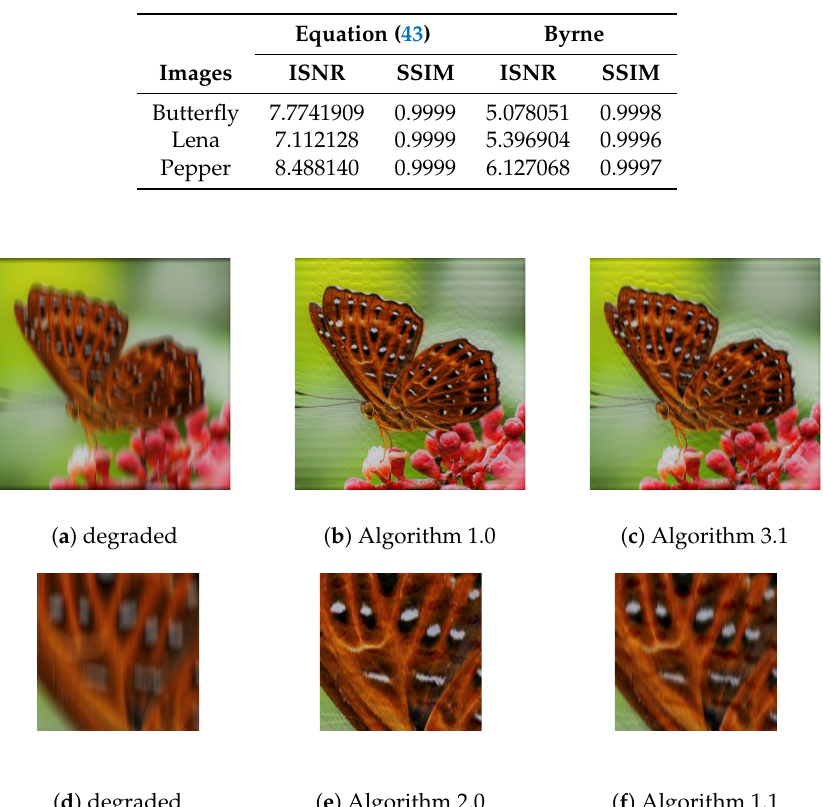
Figure 5. Degraded and restored ( a – c ) Butterfly images and ( d – f ) enlarged Butterfly images by the various algorithms.